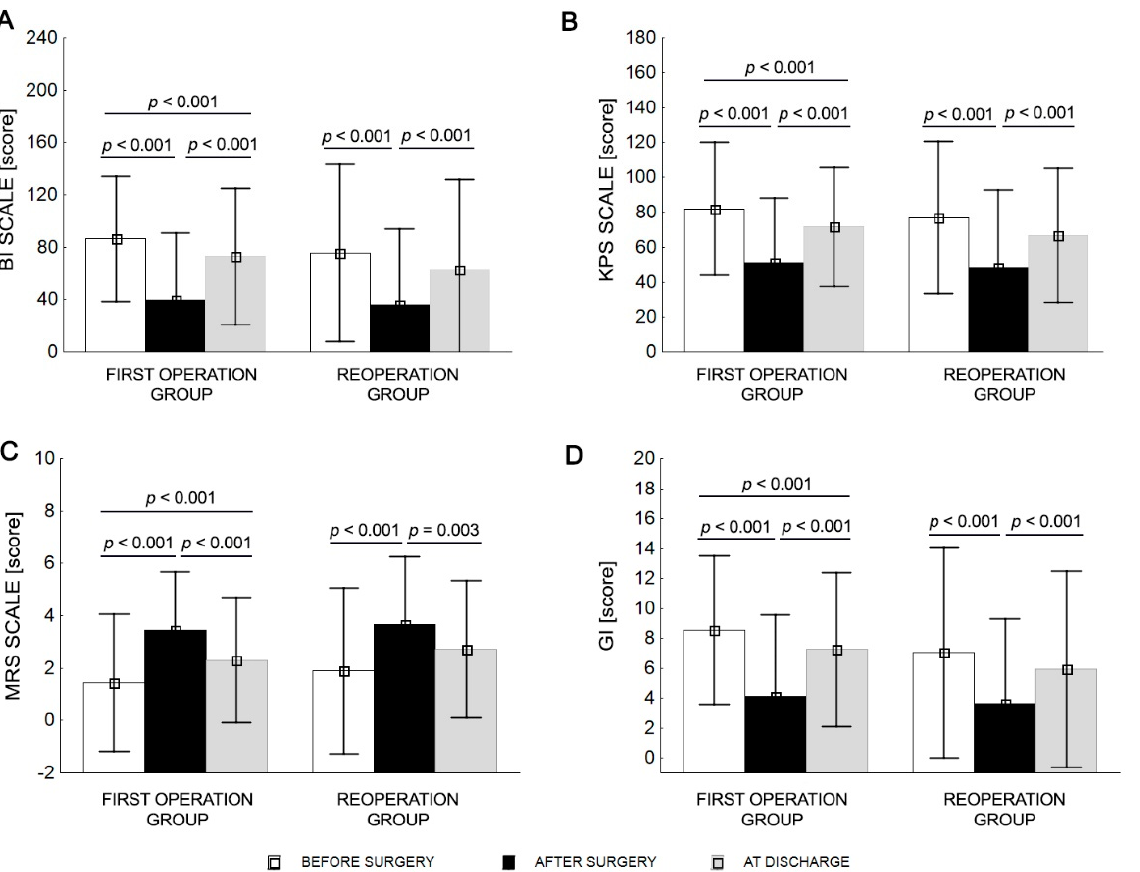
Figure 1. Mean values ( ± SD) before surgery, after surgery, and at discharge for BI ( A ), KPS ( B ), MRS ( C ), and GI ( D ). The mean BI score for the first surgery group was in the independent range (BI = 86.5), while the average BI score of patients in the repeat surgery group indicated a lack of independence (BI = 75.7) before surgery. After surgery, patients in both groups required